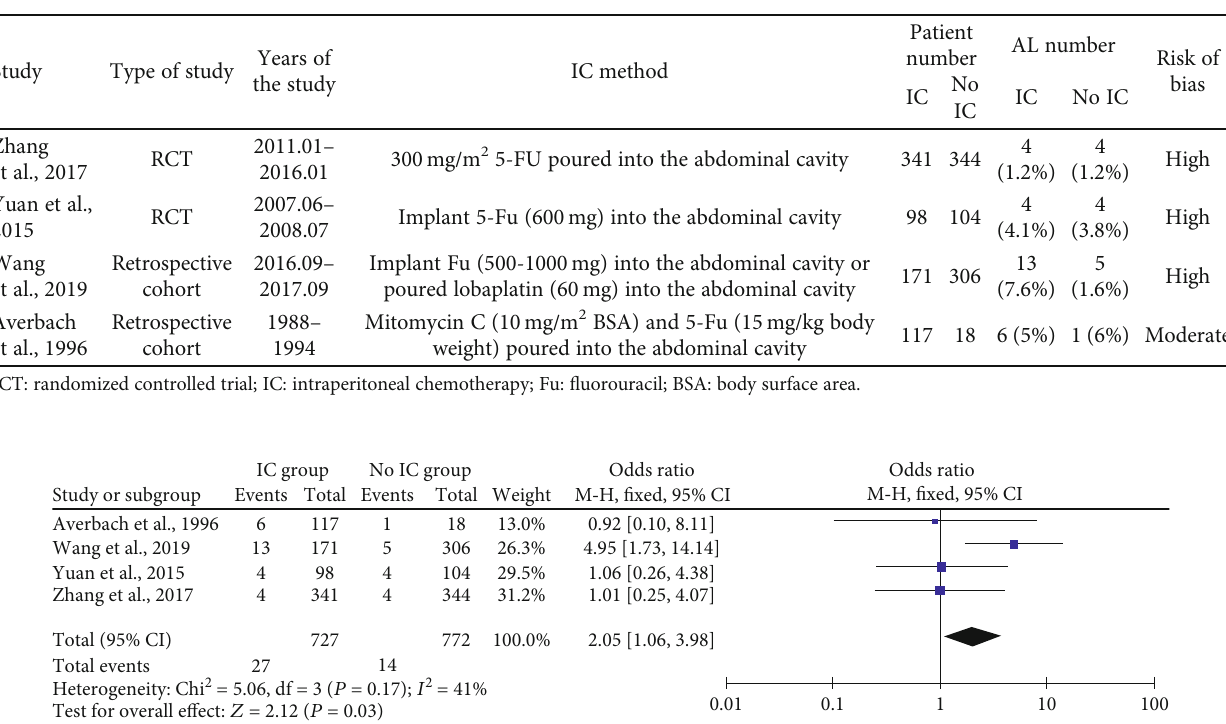
Figure 1: Flow diagram of study selection. Table 1: Basic characteristics of the included studies.